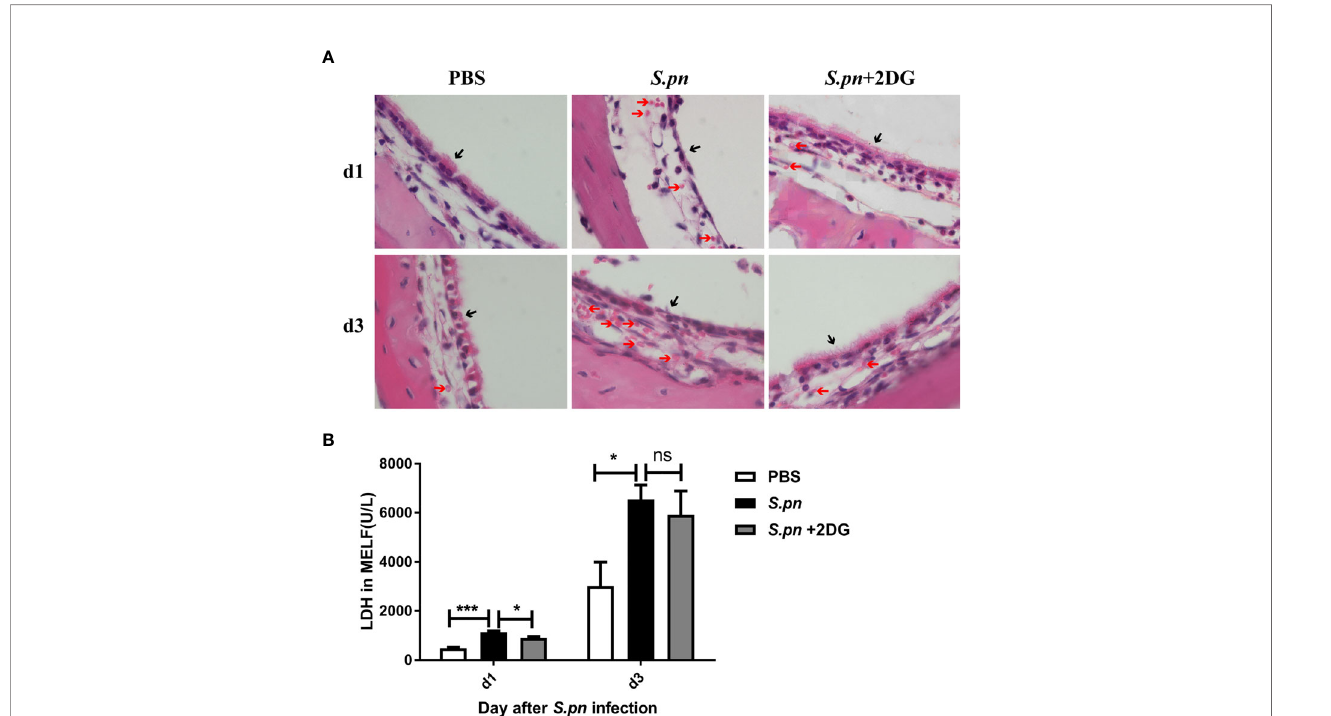
FIGURE 4 | Glycolysis aggravates middle ear tissue injury. (A) Middle ear epithelial damage was assessed by HE staining. (B) LDH activity in the supernatants of MELF was shown. Data represent three independent experiments and are presented as mean ± SD (n = 3). *P <.05; ***P <.001. ns, not signi fi